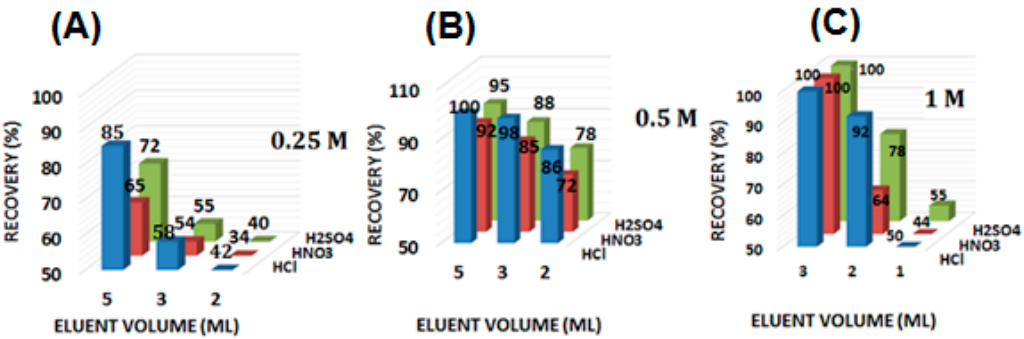
Figure 5. Effect of eluent type, volume and concentration ( A ) 0.25 M; ( B ) 0.5 M; ( C ) 1 M (experimental conditions: sample pH = 6; mass of adsorbent = 50.0 mg; flow rate = 6 mL min − 1 ; Hg 2+ = 250 mg L − 1 ; T